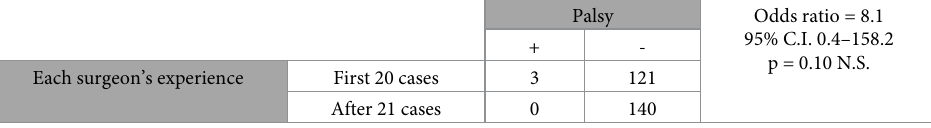
Table 3. The odds ratio of FNP following THA with DAA of the first 20 cases for a single surgeon to that of the subsequent